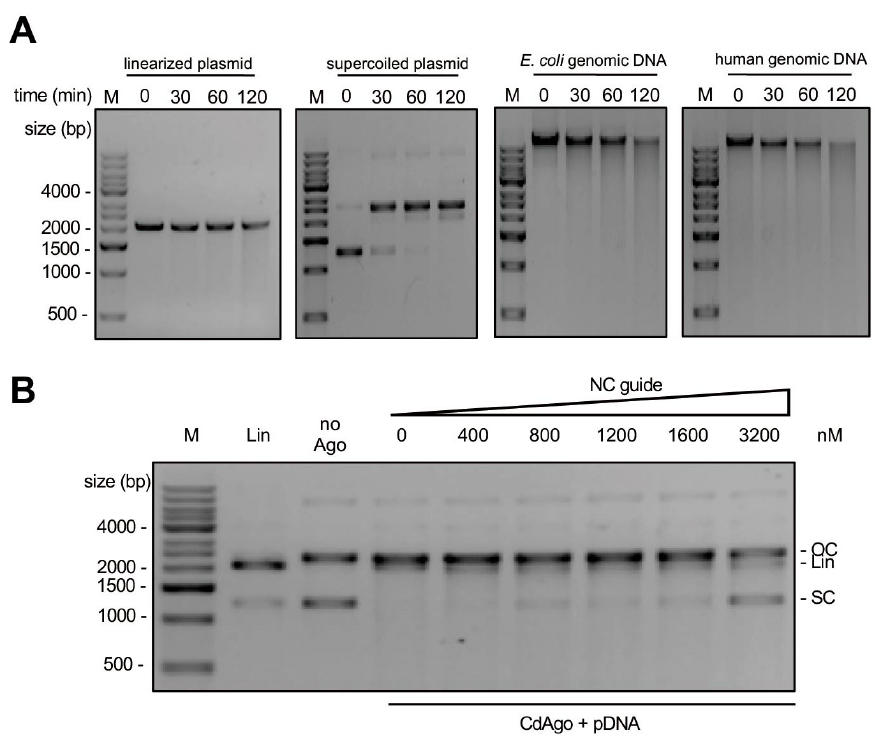
Figure 6. The CdAgo chopping activity. ( A ) Chopping of various DNA substrates with CdAgo at 37 °C. ( B ) Inhibition of the CdAgo chopping activity by increasing concentrations of NC guide (non-complementary guide DNA) at 37 °C.